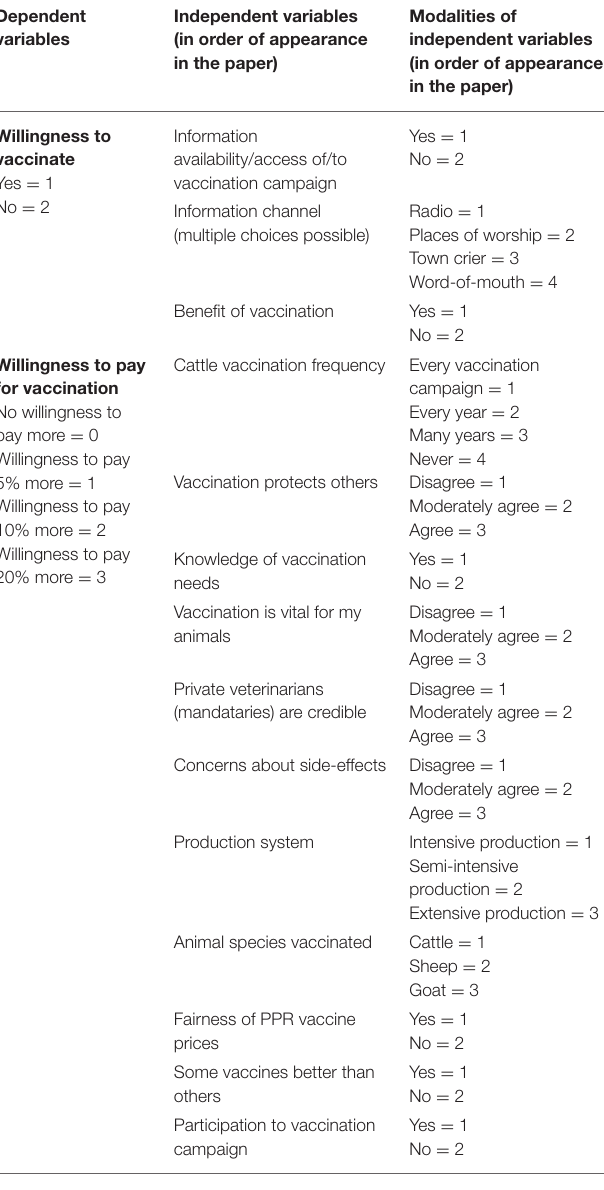
TABLE 1 | Description of variables used in the regression analyses. Dependent